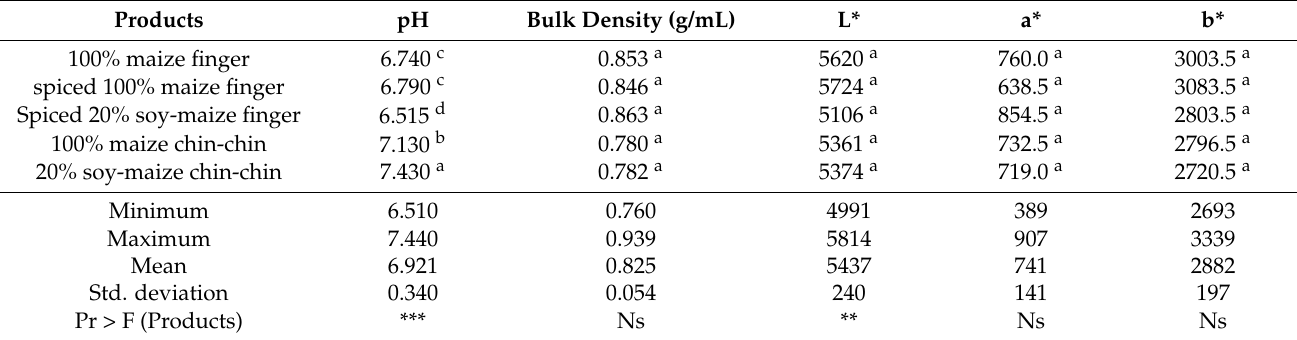
Table 3. Physicochemical properties of deep-fried maize-based